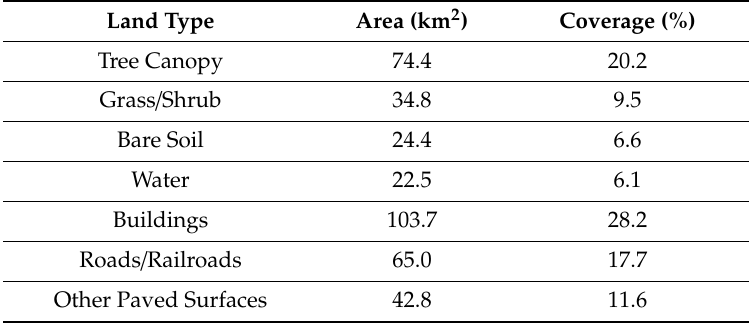
Table 1. Land types and their coverages within the city of